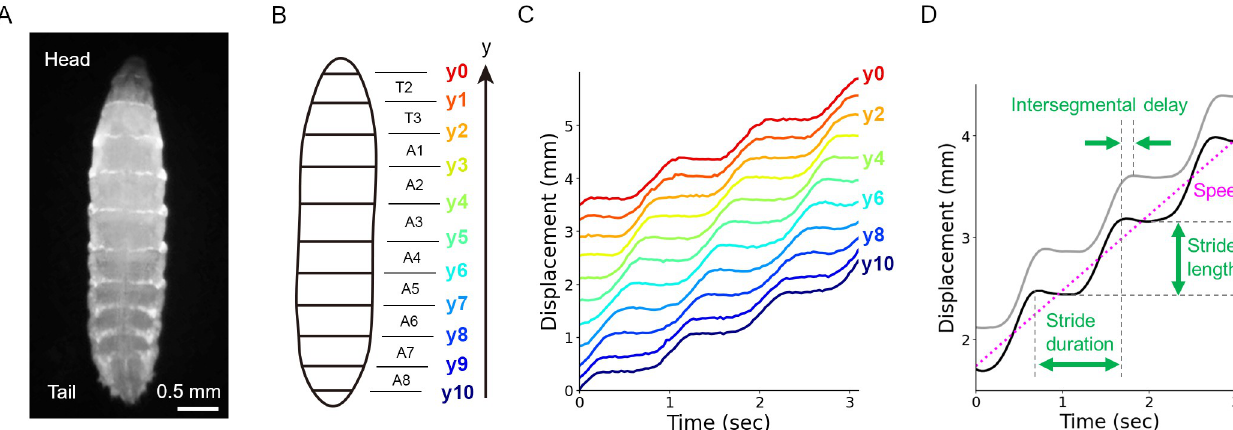
Fig 1. Kinematic parameters in fly larval locomotion. (A) A fluorescence image of a third-instar larva expressing a green fluorescent protein in muscle attachment sites. (B) A schematic of the segment boundaries (y0-y10) and the segment names (T2-A8). (C) Displacement of the segment boundaries during larval crawling. (D) Kinematics parameters based on segmental boundary dynamics. The black and grey curves represent the kinematics of one segment boundary and its adjacent anterior segment boundary, respectively. These panels are derived from Sun et al . (2022).